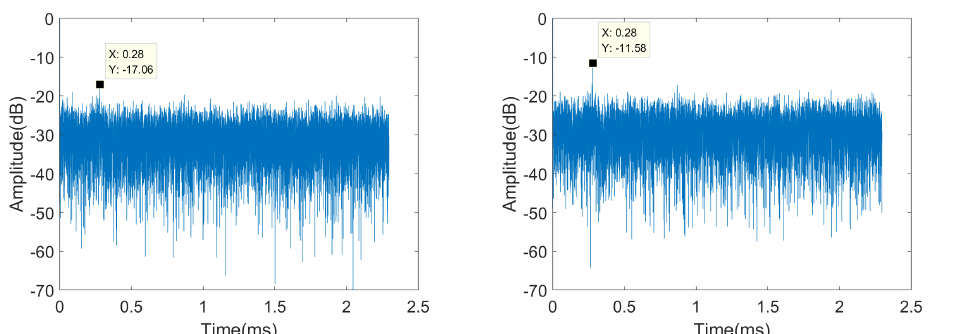
Figure 15. Results of matched filtering using intercepted direct wave signal and reconstructed reference